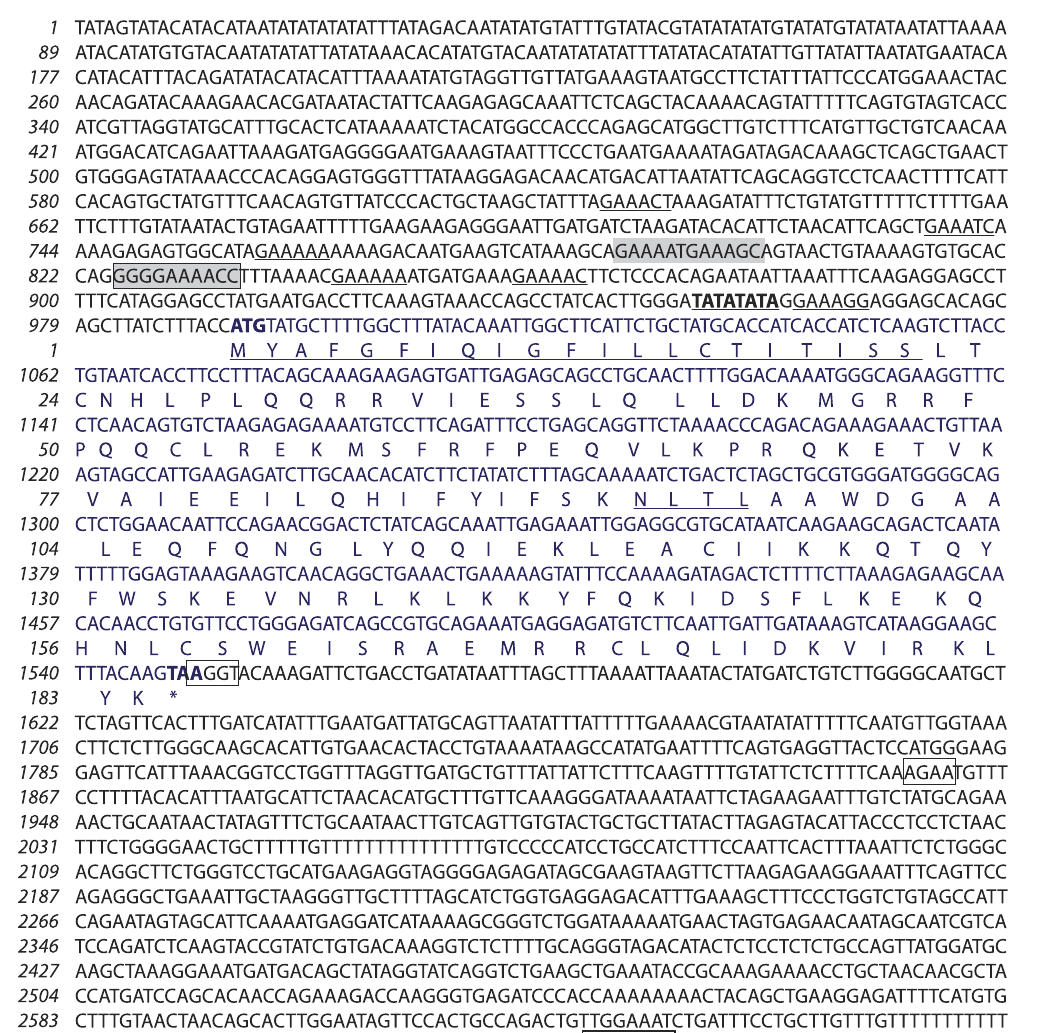
Figure 1. Structure of chIFN- κ CDS and promoter. A ~3.0 Kb genomic sequence including promoter and the CDS of chIFN- κ is shown in the reverse complement order. The ORF of the chIFN- κ is translated in uppercase and putative binding sites for IRF7 and NF- κ B transcription factors are shaded in grey. The TATA box is bold and underlined, whereas six GAAANN sites are underlined. The splice donor and accepter sites are boxed, and putative polyadenylation signal is boxed and is in bold. A predicted signal peptide and N-glycosylation site are underlined within the amino acid sequence of the chIFN- κ